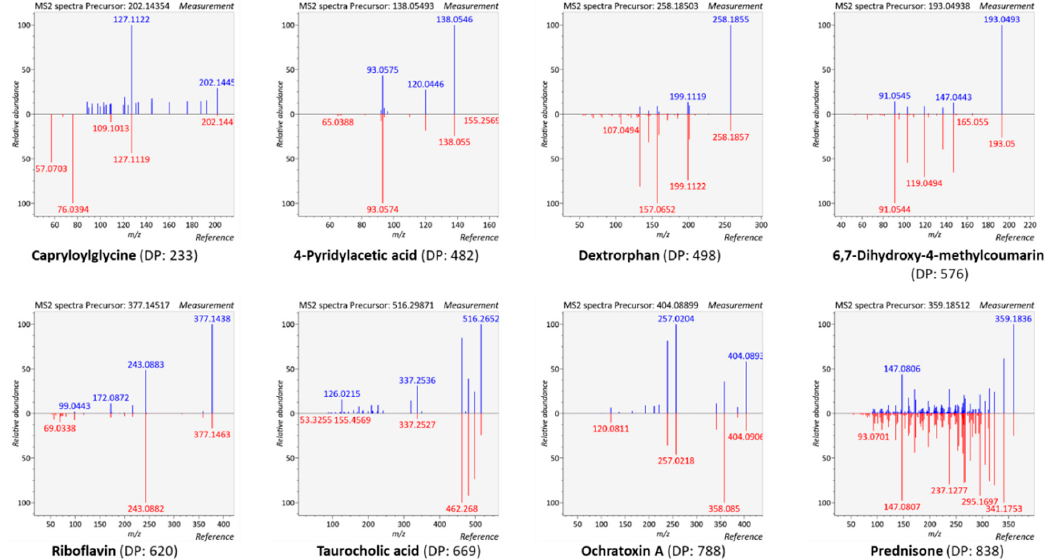
Figure 2. Head-to-tail comparison of evaluated versus reference MS / MS spectra. Evaluated MS / MS spectra were obtained using the HCD-only DDA acquisition workflow.